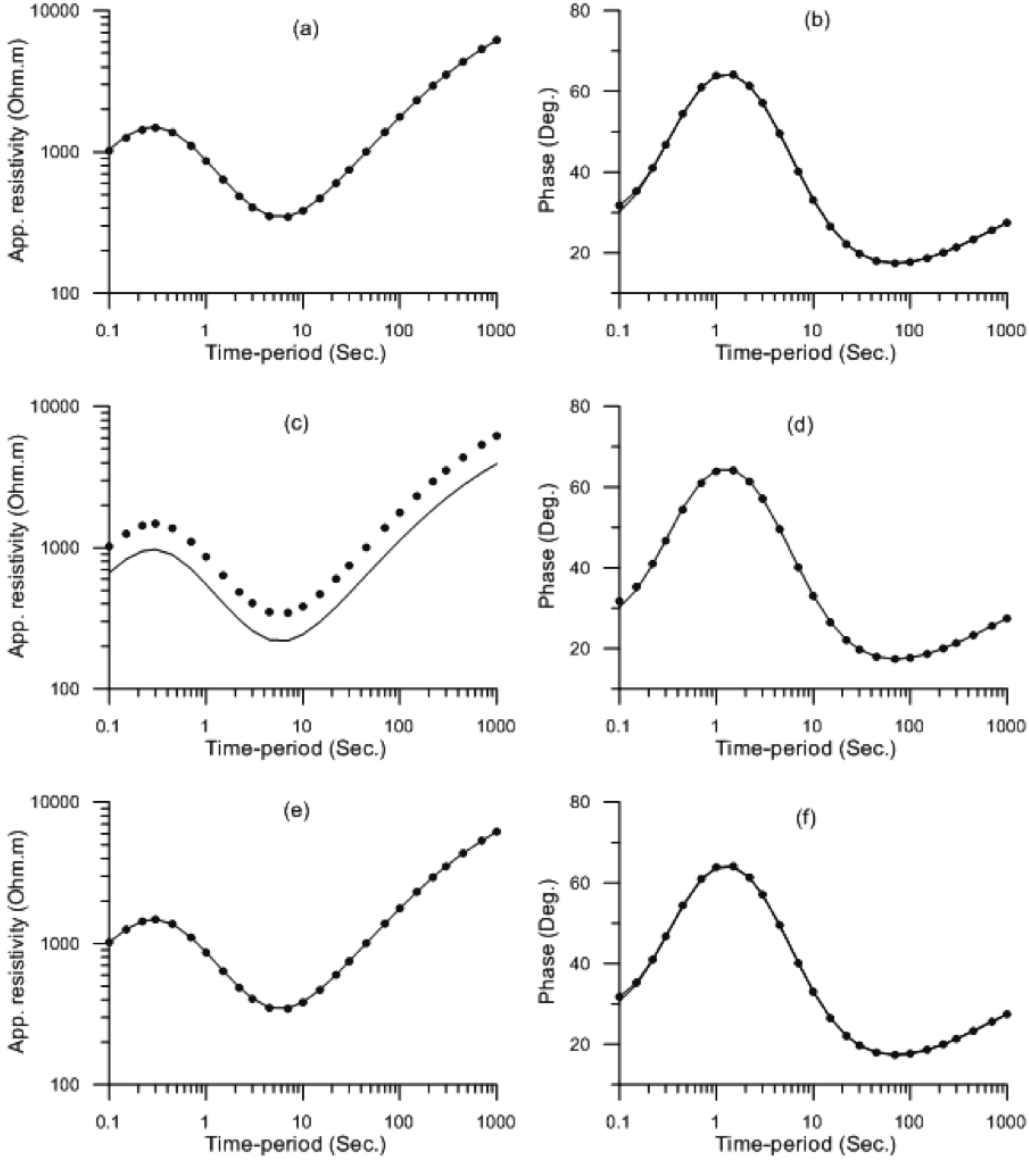
Figure 3. Comparisons between observed data (solid symbols) and model data (lines) for model 2 after inversion of the apparent resistivity data (a, b), the phase data (c, d) and both sets of data (e,